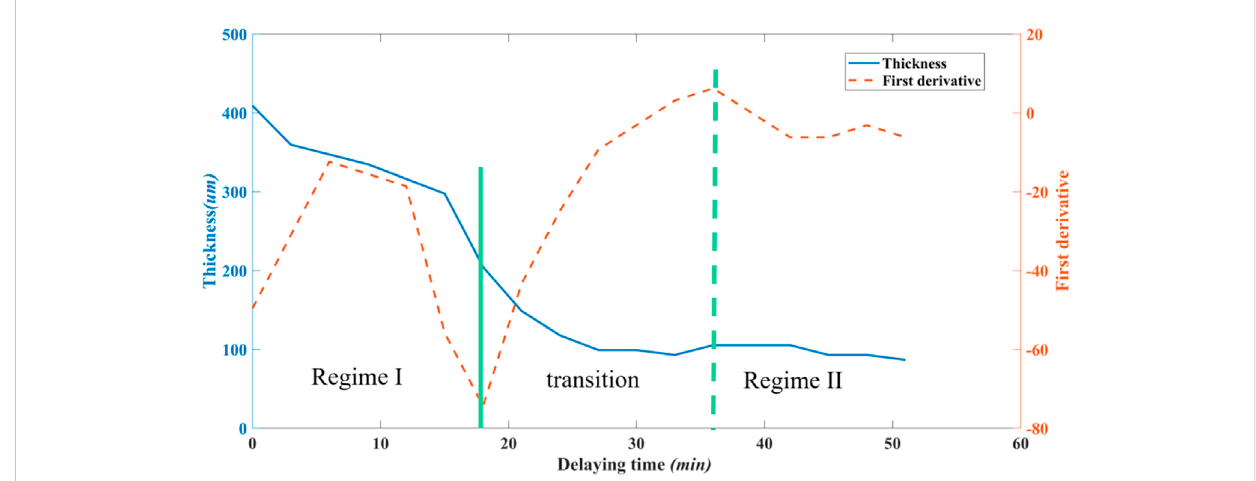
FIGURE 7 Thickness at the right edge of the OCT image and its fi rst derivative versus decaying time. Solid green line represents the valley, and dot green line represents the peak of the fi rst